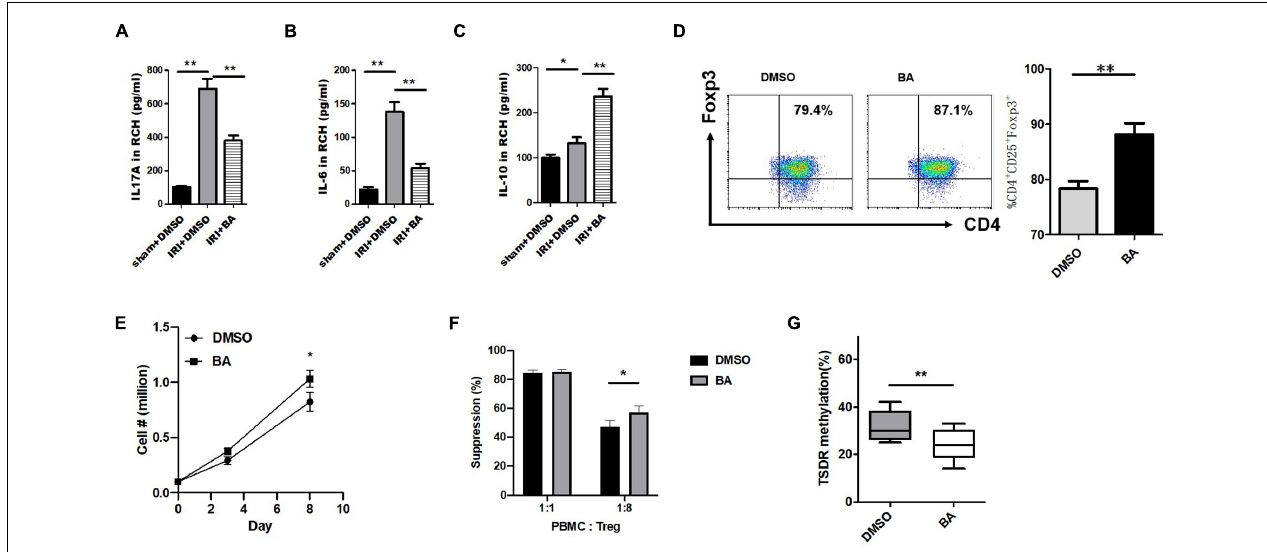
FIGURE 2 | BA regulates Foxp3 expression, cell expansion, and the function of CD4 + iTregs and inhibited IL-17A + Treg cell differentiation in vitro . (A–C) Renal cortex homogenate was collected to assay the anti-inflammatory effects of BA. The inflammatory cytokines IL-17A, IL-6 were significantly decreased after the treatment of BA in kidney IRI, while IL-10 was significantly increased. CD4 + cells (CD4 + CD62L High CD44 Low ) isolated from C57/B6J mouse spleens were cultured under Treg polarizing conditions with BA or placebo. The expression of Foxp3 was significantly increased in the cells treated by BA within 8 days after induction. Compared with the control group, the absolute number of CD4 + iTregs in BA group was slightly increased on day 8 while the difference was not significant on day 8. The suppressive ability of BA-CD4 + iTregs was estimated by CFSE coculture assays. Although there was no difference in suppressive ability at 1:1 (Treg:CD4 + effector T cells), BA-CD4 + iTregs showed stronger inhibition at 1:8. We used bisulfite sequence analysis to detect the methylation status of CD4 + iTregs induced by BA. And compared with the control group, there were fewer methylated CpG sites in BA-CD4 + iTregs. Sample size = 3 in each group. Data were presented as mean ± standard deviation. N.S. P > 0.05, * P < 0.05, ** P < 0.01.